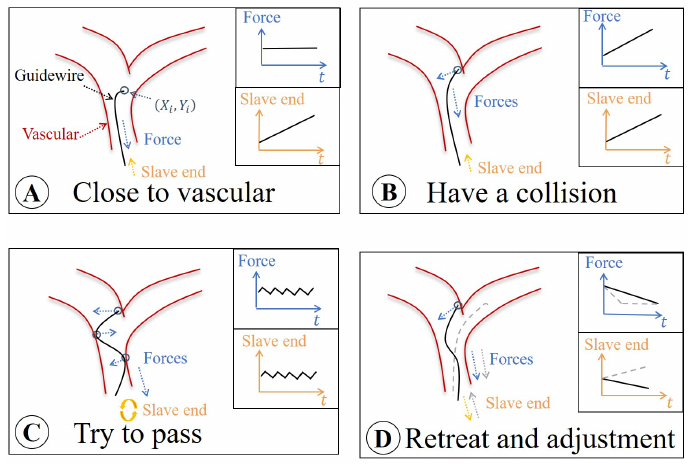
Figure 8. Sketch map of guidewire operation in vascular